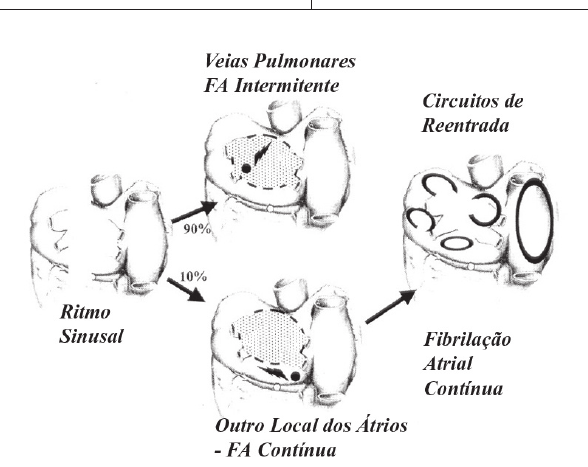
Fig. 1 - Bases eletrofisiológicas das duas formas clínicas